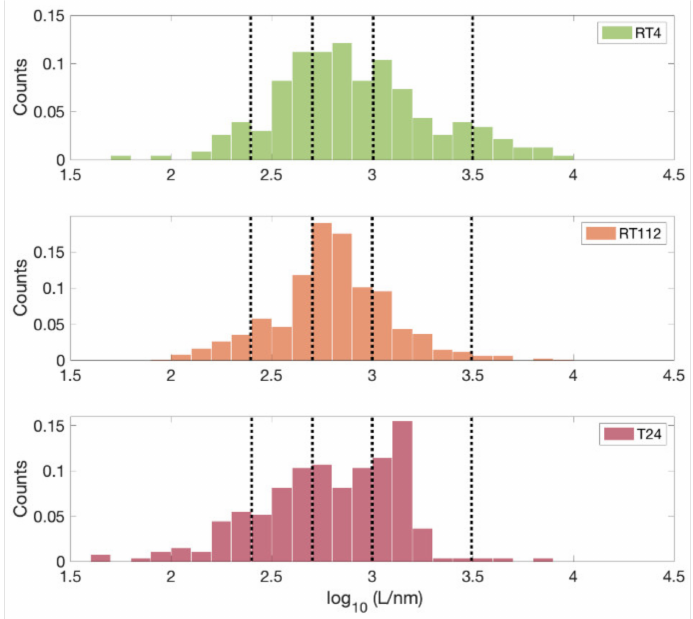
Figure 9. Distribution of the lengths of the glycocalyx brush (extracted according to Equation (9) from single FCs) for the three cell lines RT4, RT112, and T24. Vertical dotted lines are a guide for the eye in the tentative identification of the main modes of the